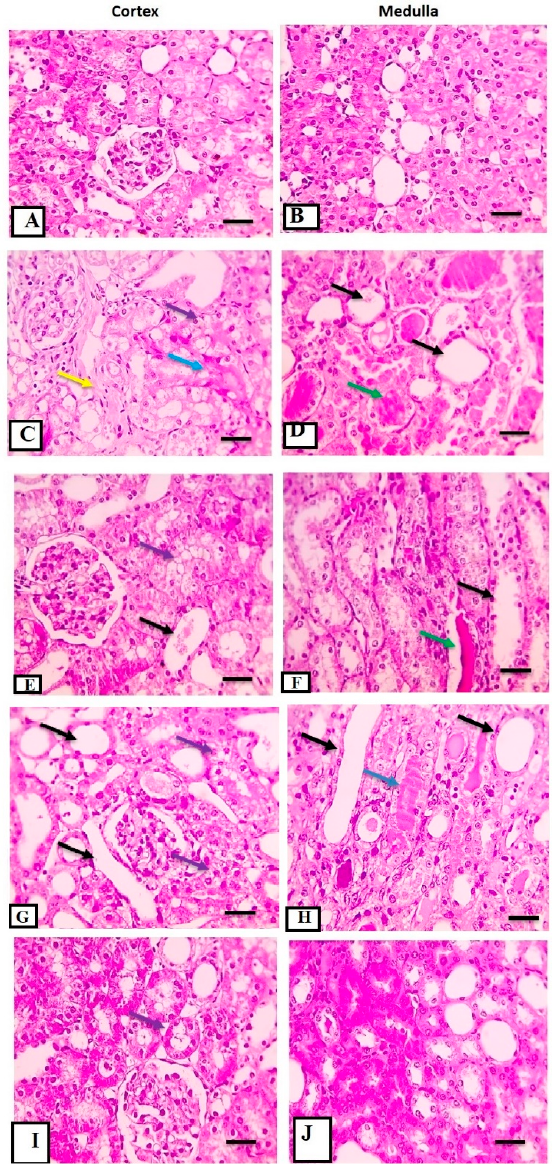
Figure 4. Microscopic pictures of H&E-stained renal sections from rats for treatment groups (i) to (v). (i) The sham group on day 7 shows the normal structure of glomeruli, PCT, and DCT in the cortex ( A ) and normal tubules in the medulla ( B ) (high magnification 400 × , scale bar 50 µ m). (ii) The IRI group shows dilated irregular tubules with attenuated epithelial lining (black arrows) with apoptotic cells (red arrows), tubular hyaline casts (green arrows), degenerated (violet arrows) and necrotic (blue arrows) epithelial lining, interstitial fibrosis infiltrated with inflammatory cells mainly lymphocytes (yellow arrows) in the cortex ( C ) and medulla ( D ) (high magnification 400 × , scale bar 50 µ m). (iii) The ATRA group shows a decrease in severe tubular dilation (black arrows), degeneration (violet arrows) and cast formation in the cortex ( E ) and medulla ( F ) (high magnification 400 × , scale bar 50 µ m). (iv) The WJ-MSCs group shows milder lesions than recorded in the IRI group and ATRA group characterized by mild tubular dilation and degeneration (violet arrows) in the cortex ( G ) and medulla ( H ), infrequent cast formation and few apoptotic cells (high magnification 400 × , scale bar 50 µ m). (v) The ATRA + WJ-MSCs group shows much milder lesions than recorded in previous groups characterized by very mild tubular dilation and degeneration (violet arrows) in the cortex ( I ) and medulla ( J ) and infrequent cast formation in the medulla (high magnification 400 × , scale bar 50 µ